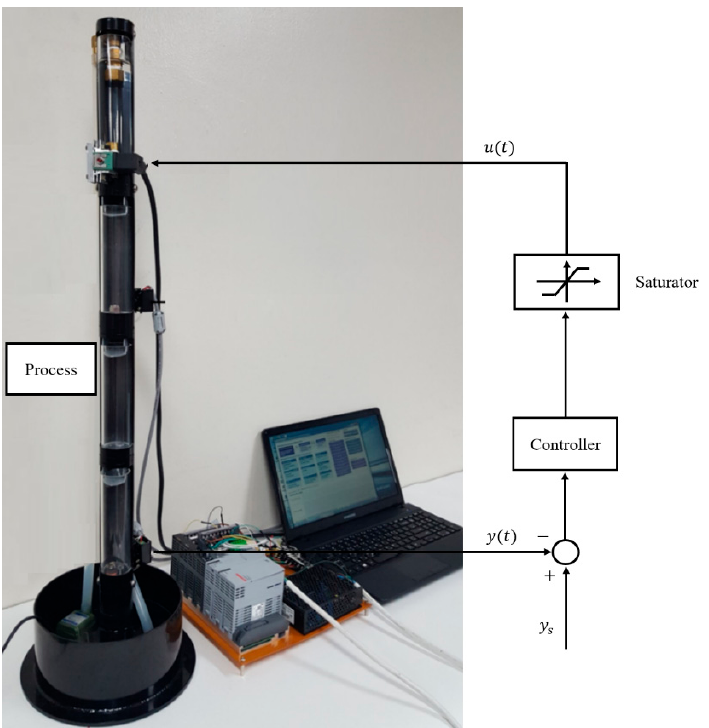
Figure 21. Liquid level control system.